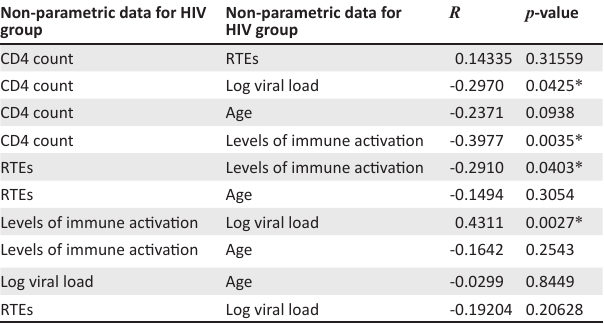
FIGURE 2: Baseline levels of % of CD38+/CD8+ T-cells in HIV-positive versus control TABLE 2: Spearman’s R correlations for HIV group. Non-parametric data for HIV Non-parametric data for group HIV group